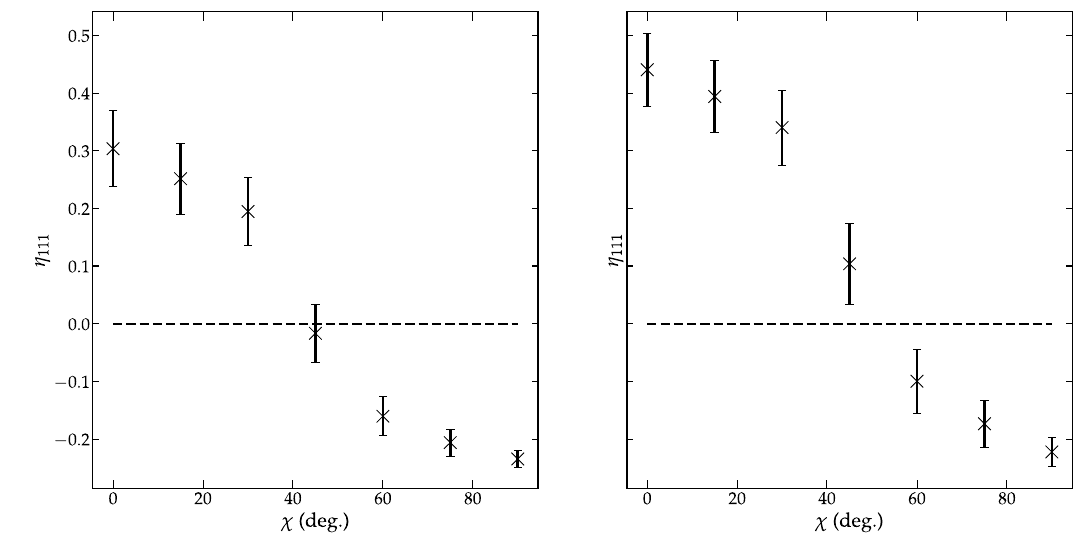
Figure 6. Normalization has a substantial impact on the determined fraction of domains aligned into the field direction. Data normalized using an experimental reference though peak fitting of data before poling ( left ) estimates a higher degree of domain alignment than a calculated equivalent random intensity ( right ).